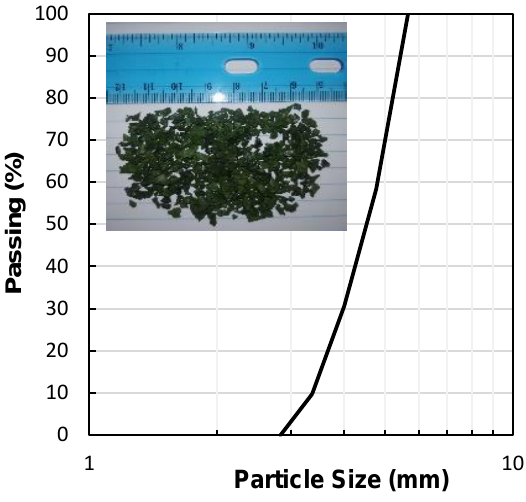
Figure 1. Gradation curve for granulated rubber.